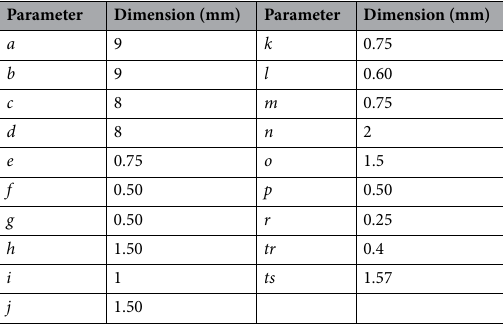
Table 1. Design parameters of anticipated structure with their value .